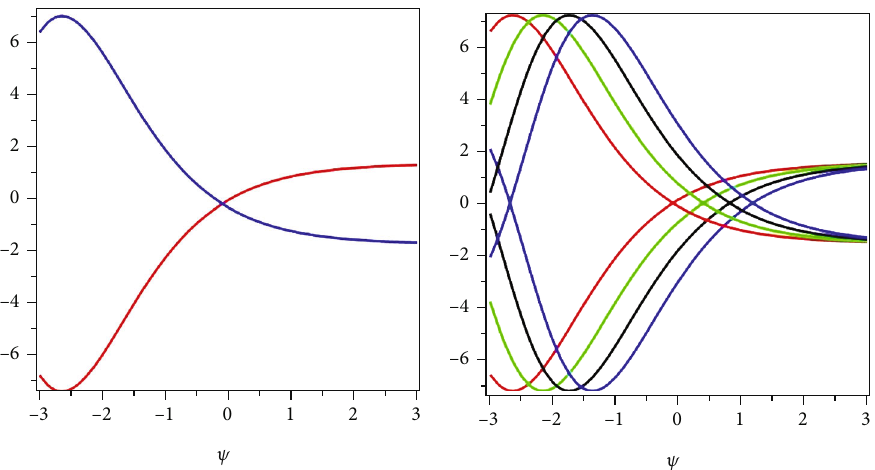
Figure 3: (a) 2D upper and lower fuzzy branch plots of the approximate series result and (b) the di ff erent fractional order of ς